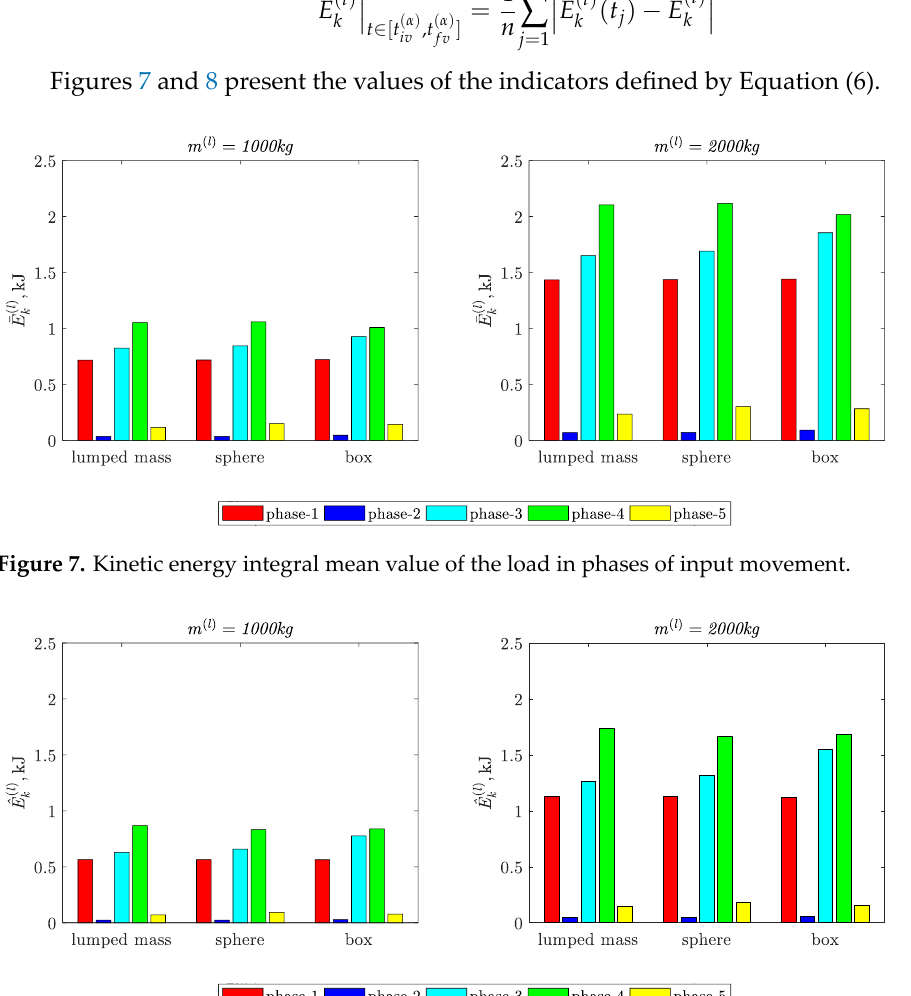
l E and en- ,max k